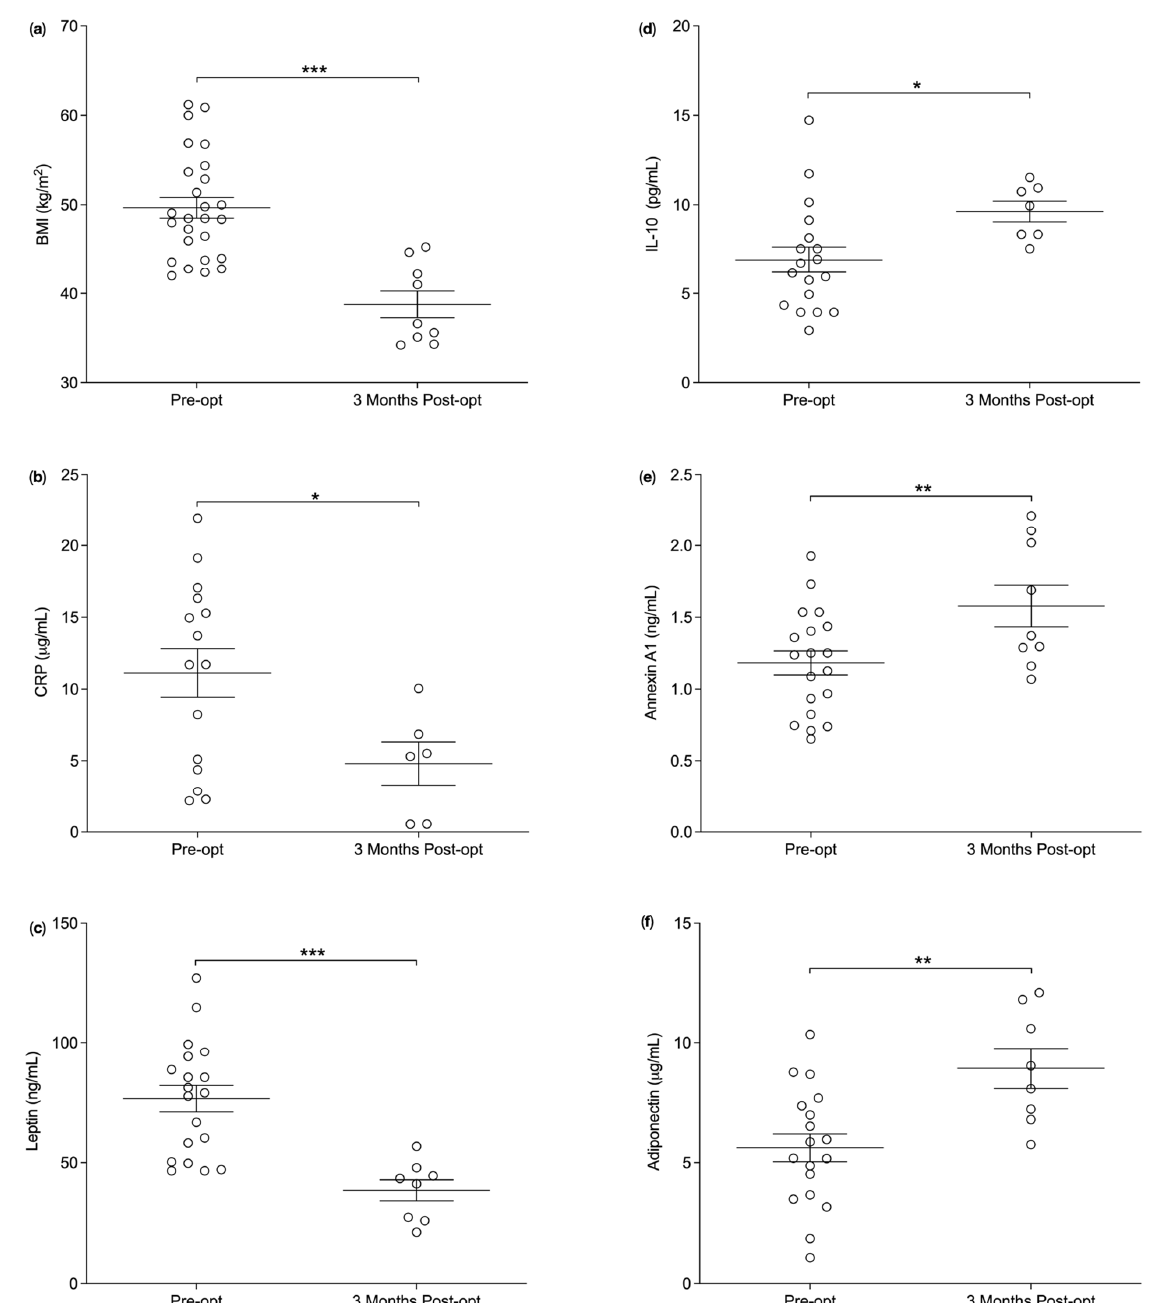
Figure 1. Average biomarker concentrations of participant cohort pre- and post- Bariatric